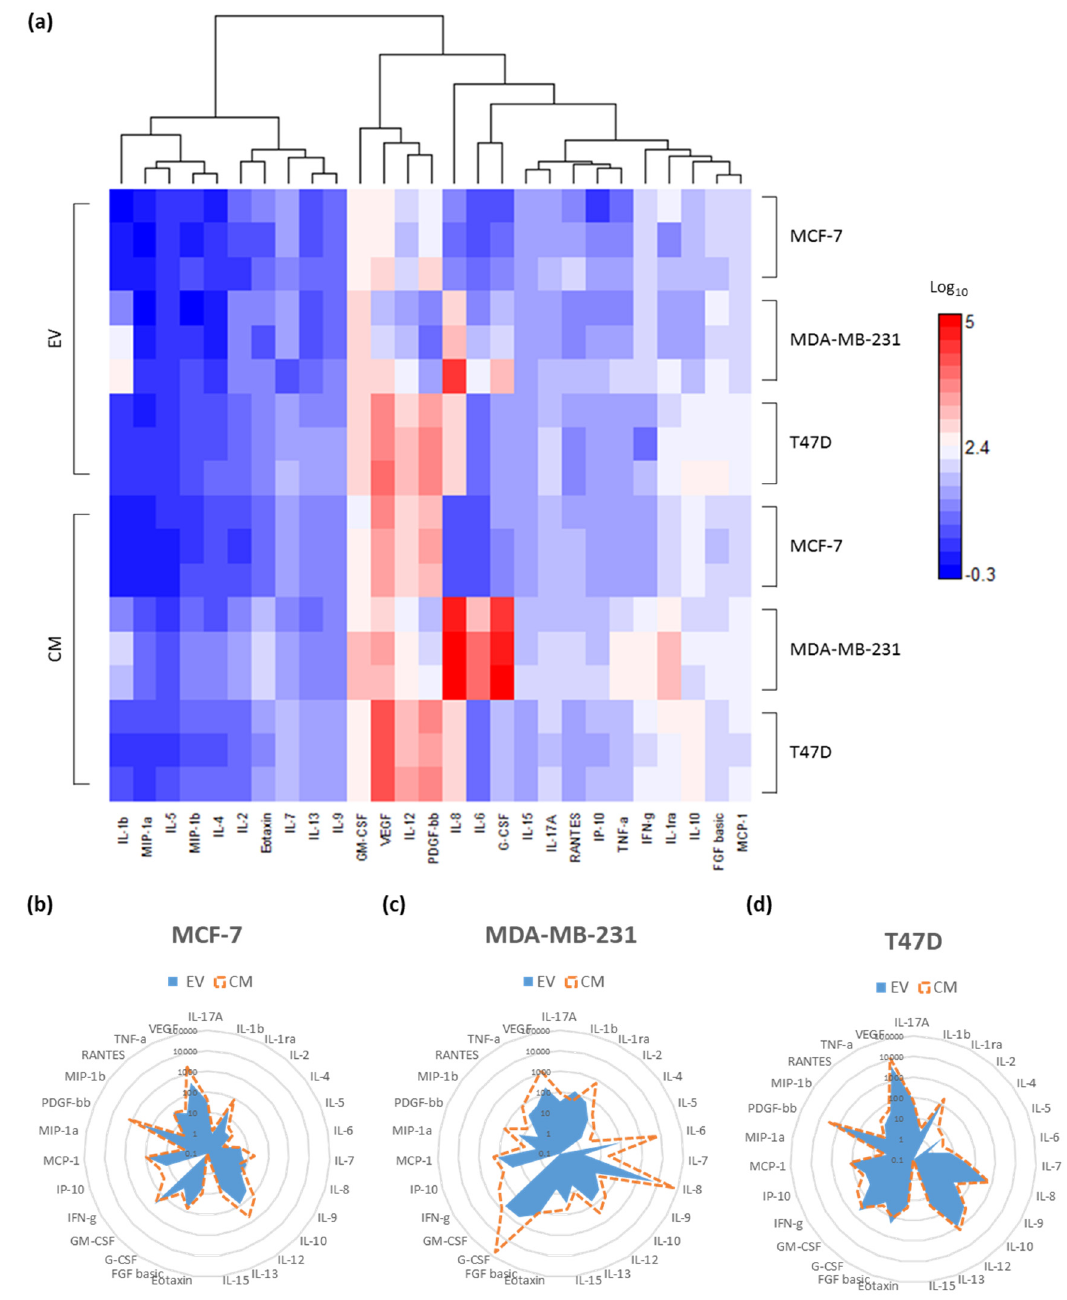
Figure 1. Comparisons of cytokines found in the conditioned media and associated with the extracellular vesicles (EVs) from MCF-7, MDA-MB-231 and T47D cell lines. ( a ) Heatmap depiction with hierarchical clustering using correlation clustering equation of the cytokines was carried out using DanteR software. Concentrations are in Log 10 pg / mL. Red: high concentration, blue: low concentration and white: medium concentration of cytokines. Radar graphs comparing the mean abundance of each cytokine in each of the conditioned media, and those associated with the collected EVs for the ( b ) MCF-7 ( c ) MDA-MB-231 and ( d ) T47D cell lines ( n = 3). The values are in picograms per millilitre and displayed on a logarithmic scale. Blue solid line: EVs and red dotted line: CM. In order to quantify the differences between the CM and EV, the percentage of each cytokine